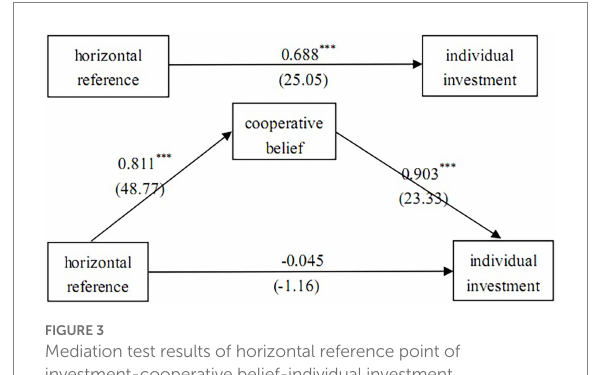
FIGURE 3 Mediation test results of horizontal reference point of investment-cooperative belief-individual